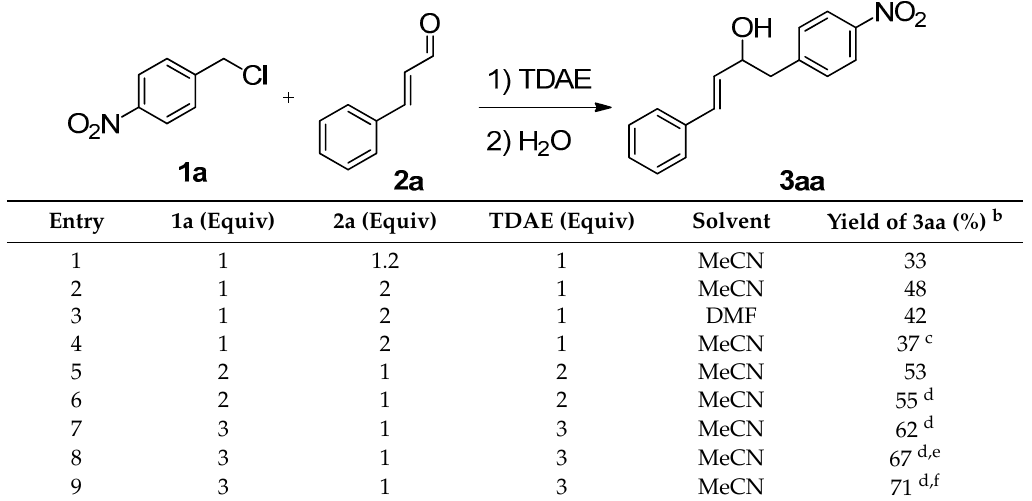
Table 1. Optimization of the 1,2-addition of p -nitrobenzyl chloride 1a to trans -cinnamaldehyde 2a in the presence of TDAE a .